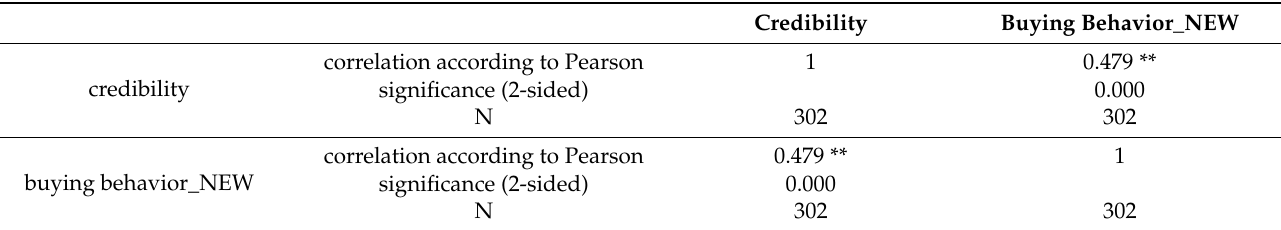
Table 4. Correlations H2.